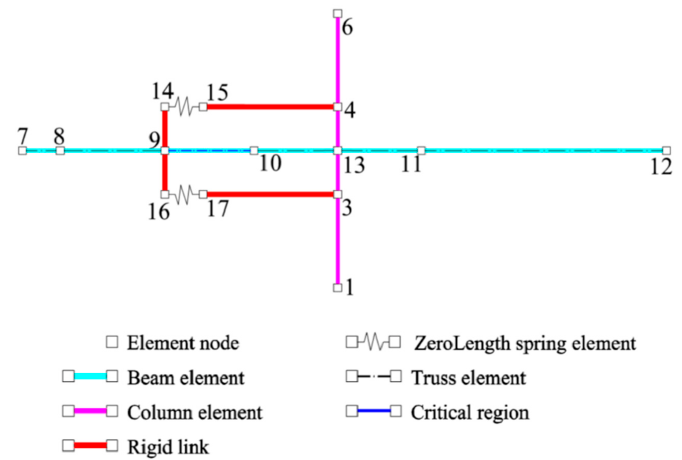
Figure 11. Analytical connection model of the novel S CPC frame with Opensees.